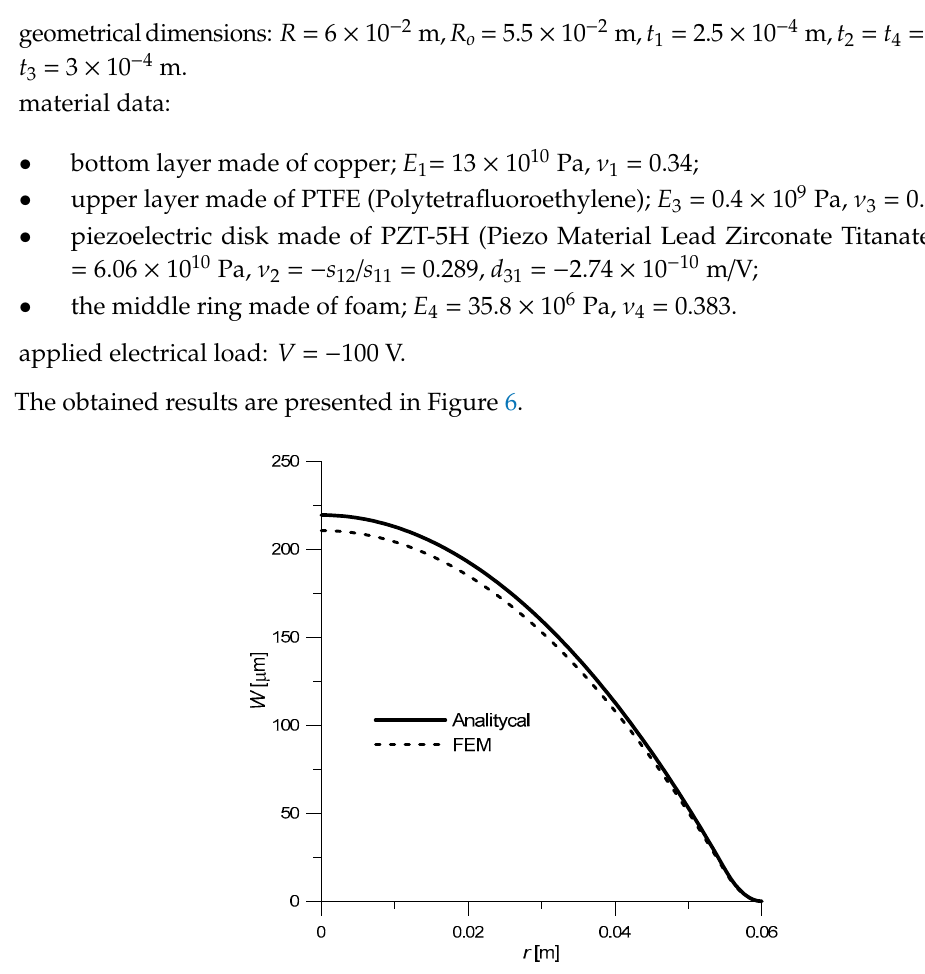
Figure 6. Comparison of deflection curves for the three-layer transducer: solid line—analytical solution (20); dashed line—FEM (Finite Element Method) solution; V = − 100 V.